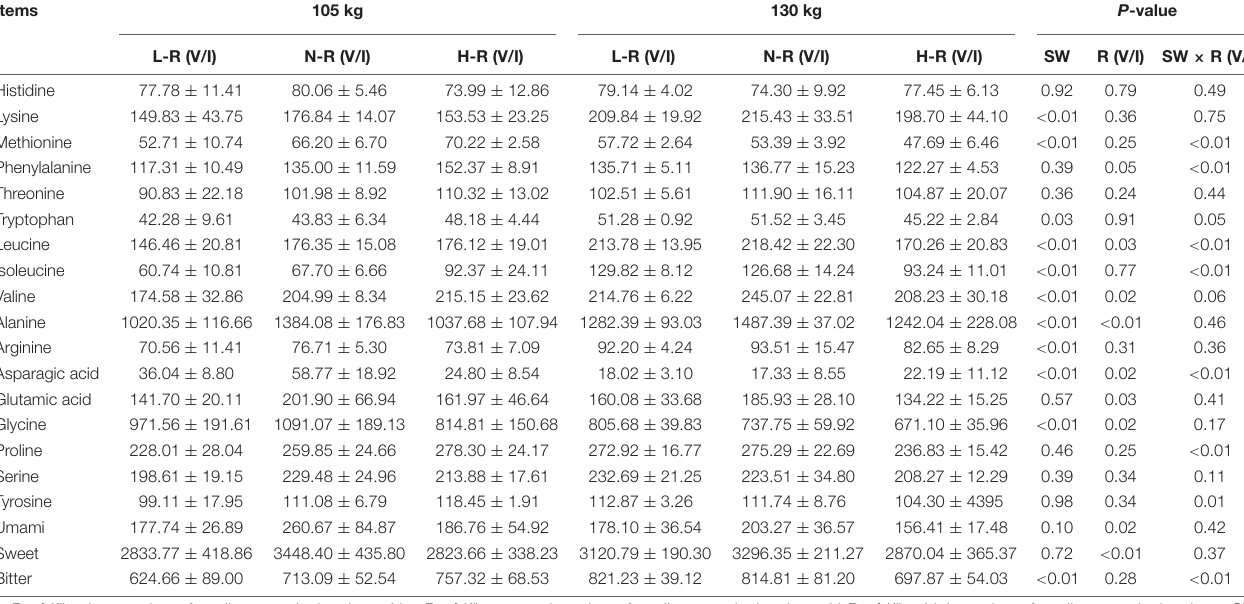
TABLE 5 | Effect of dietary R (V/I) and slaughter weight on muscular free amino acid concentration in finishing pigs (nmol/g, n = 6). Items 130